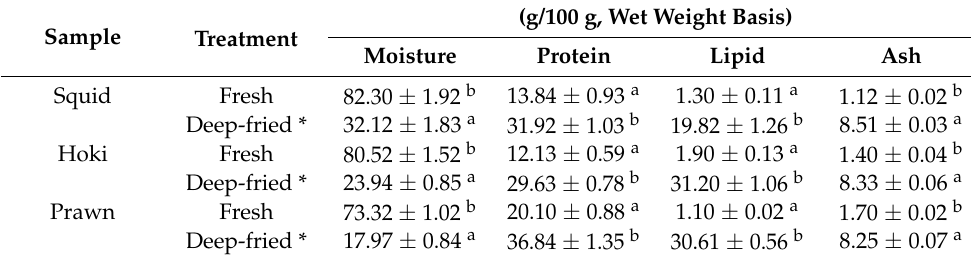
Table 2. Proximate composition of